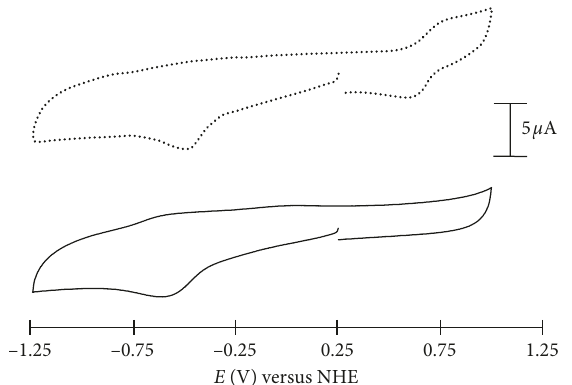
Figure 4: Cyclic voltammetry of 1mM of 2 in DMSO with the internal Fc/Fc + standard (top) and without (bottom).